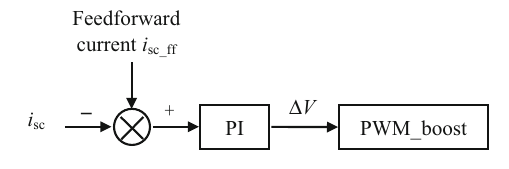
Fig. 11 Load current feedforward control